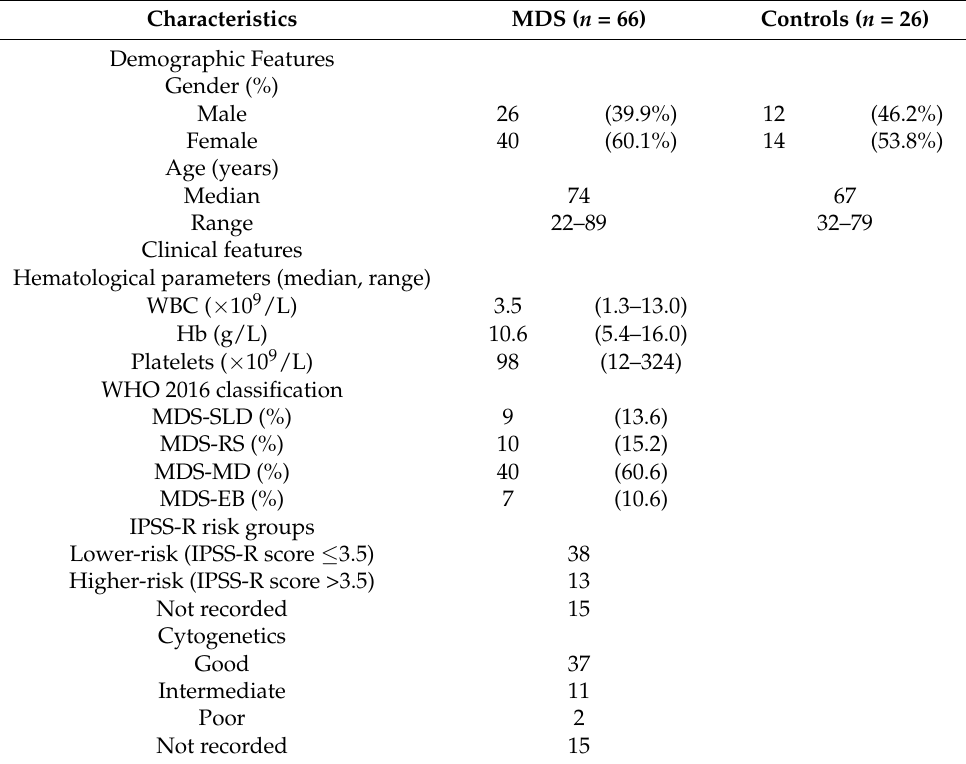
Table 1. Biodemographic and clinical characteristics of MDS